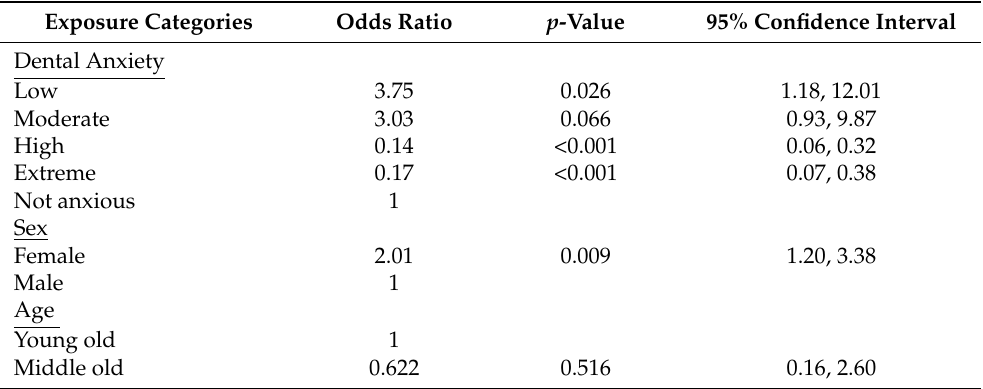
Table 7. Association between dental anxiety level and oral-health-related quality of life, controlling for sex and